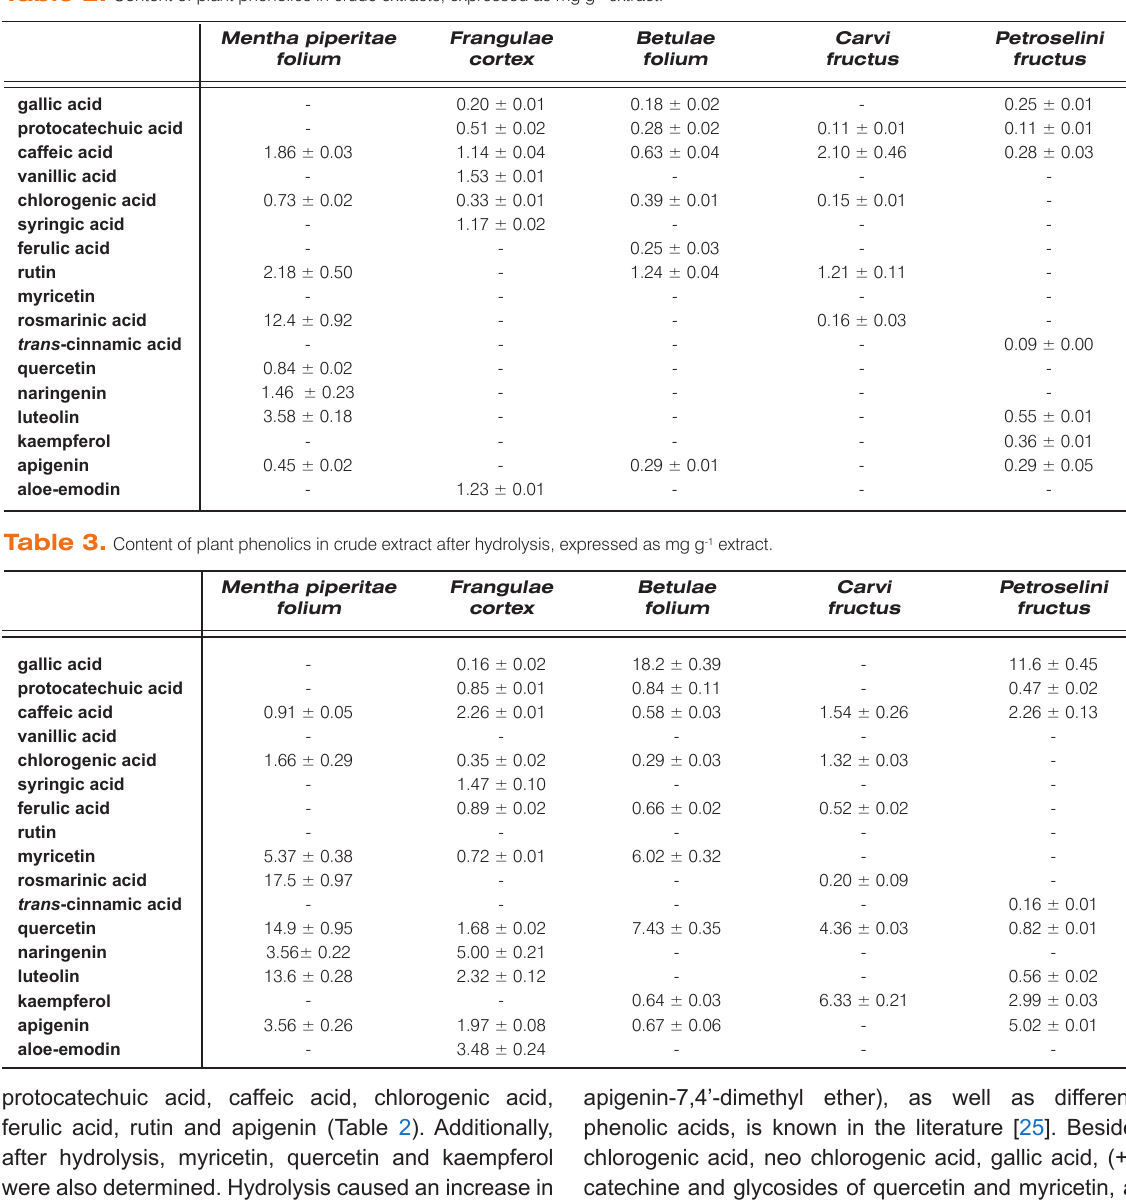
Table 2. Content of plant phenolics in crude extracts, expressed as mg g -1 extract.